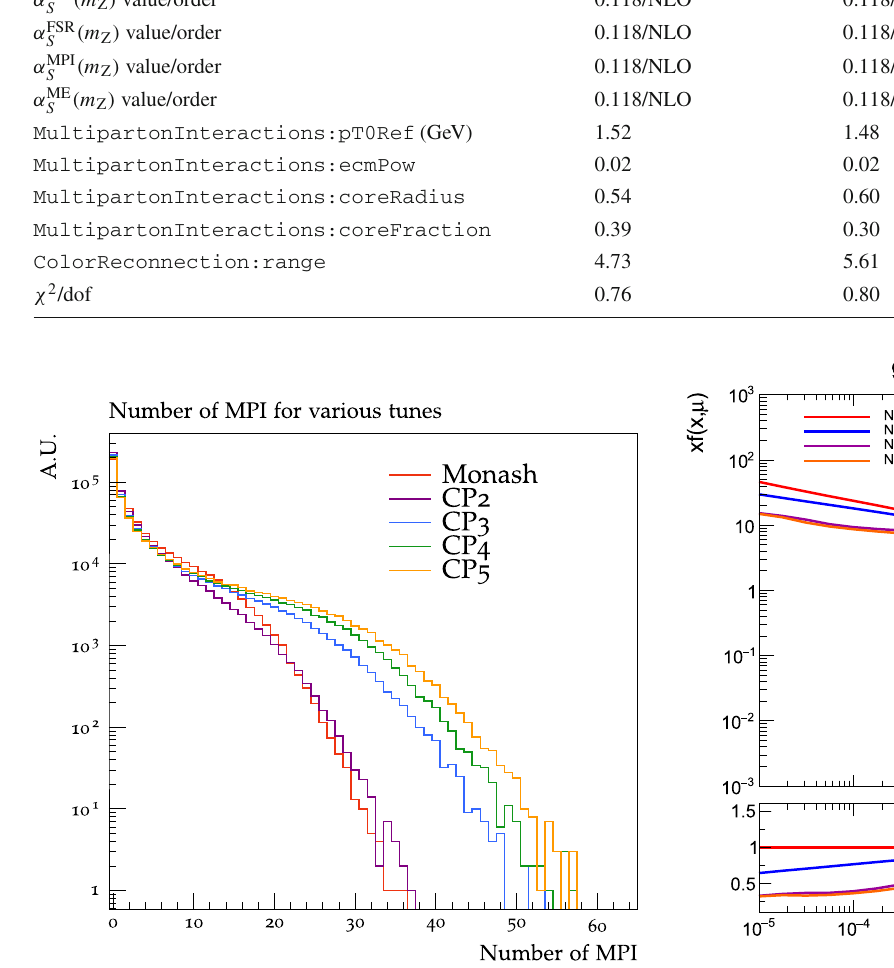
Fig. 3 Distribution of number of MPI simulated by the tunes Monash, CP2, CP3, CP4, and CP5 (left). Gluon distribution function at a refer- ence scale of μ = 3GeV (right) for the NNPDF2.3LO PDF set and the